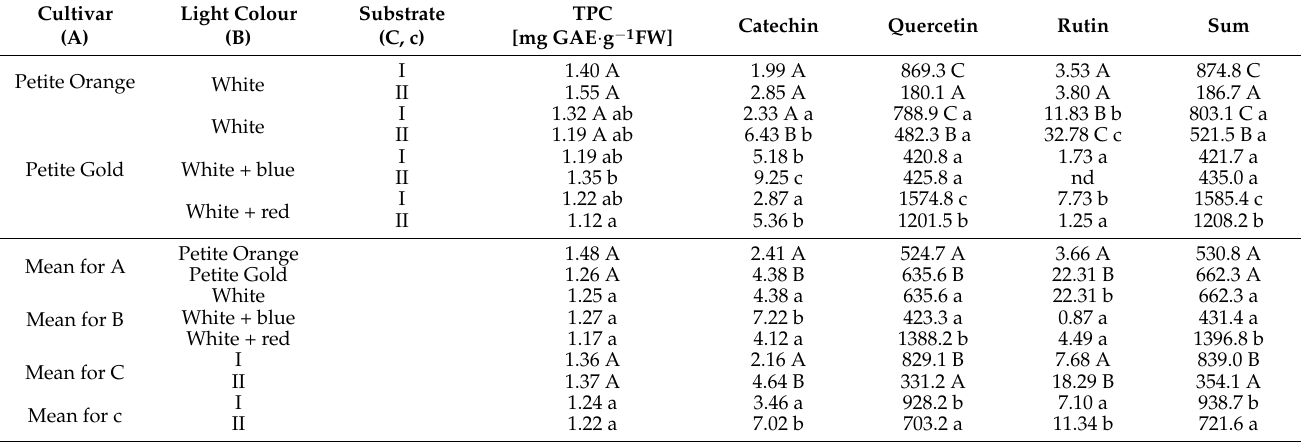
Table 3. Profiling of flavonoids and total phenolic content of the Tagetes patula flowers depending on cultivar and substrate under white light (big letters) and profiling of flavonoids of the Tagetes